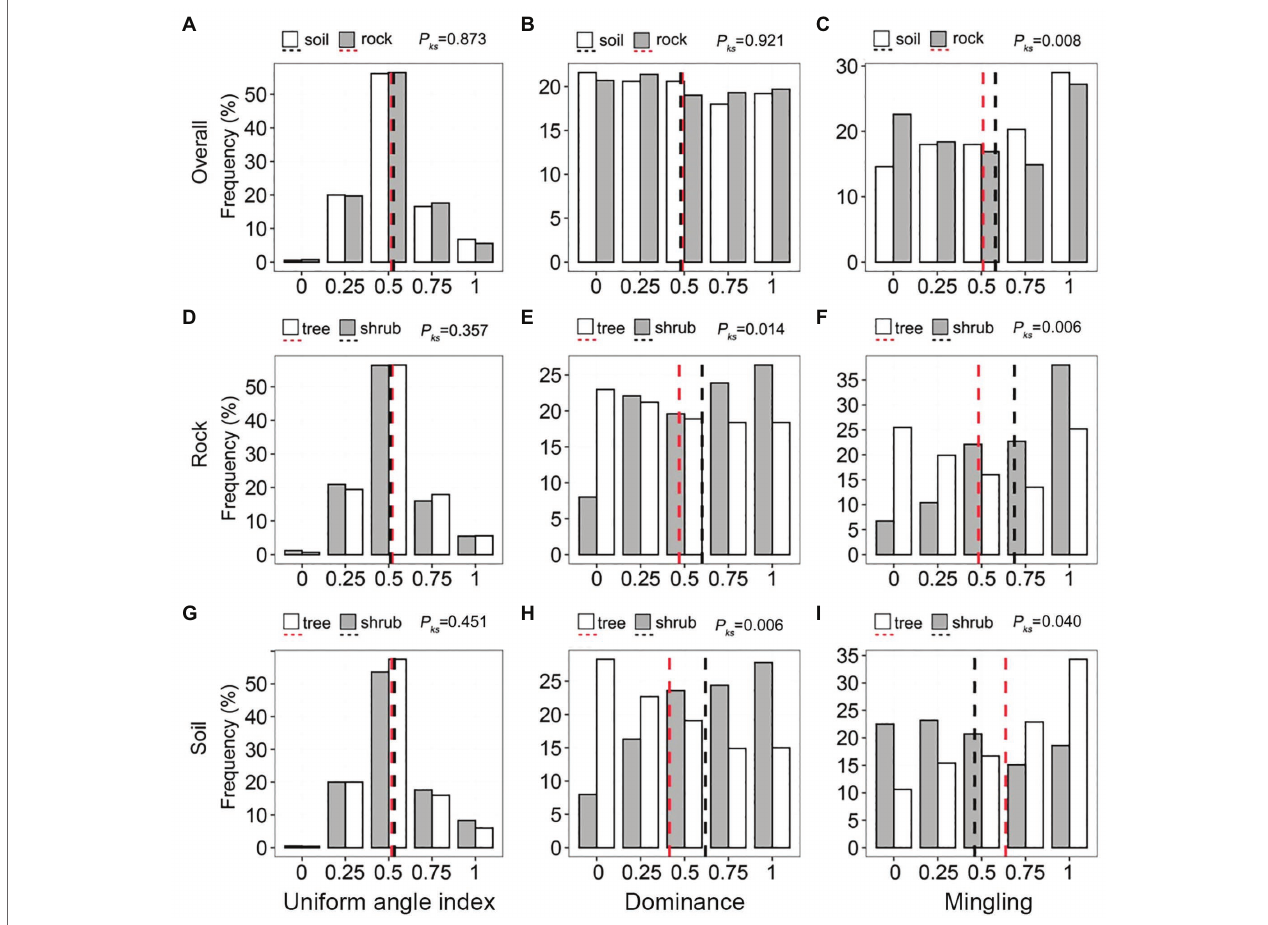
FIGURE 5 | Univariate distributions of the stand spatial structure parameters of trees and shrubs on rock and soil. The red and black dashed lines represent the mean values of each parameter. p ks > 0.05, 0.01 < p ks < 0.05, and p ks < 0.01 represent non-significant, significant, and highly significant differences,